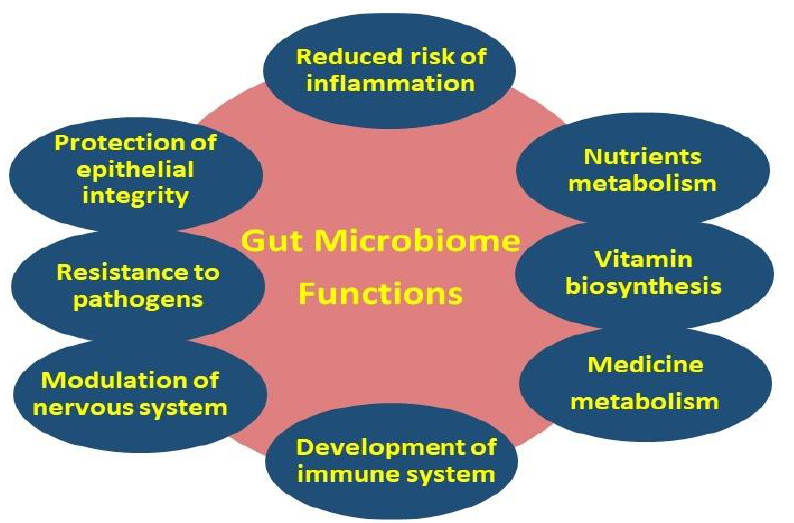
Figure 3. Primary (i.e., metabolism, gut–brain axis, and protection of epithelial integrity) and secondary (i.e., nutrients, vitamin and medicine metabolism, regulation of the immune and nervous systems, and resistance to pathogens) gut microbiome functions.